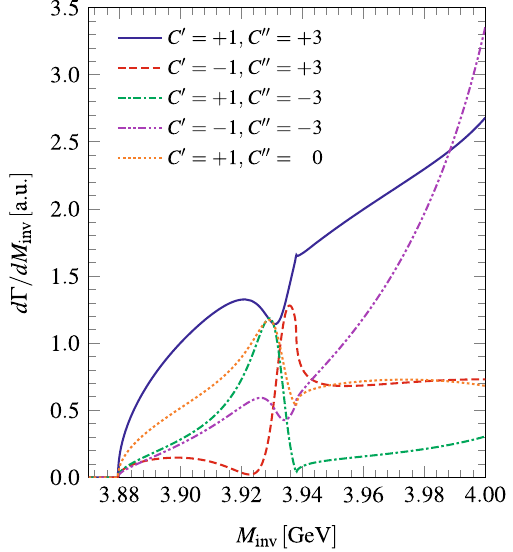
+ → K + J /ψ ω ,asafunc- √ s ,withdifferentvalues